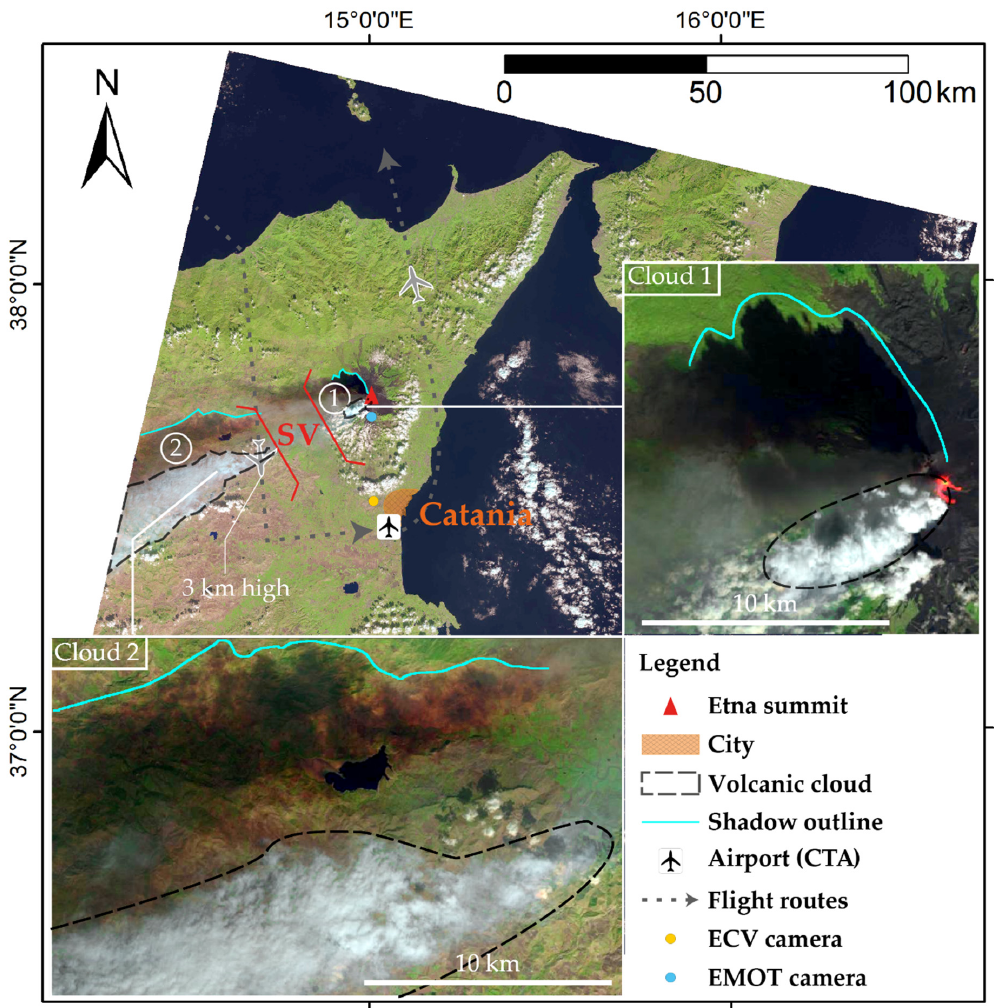
Figure 1. Ortho-rectified Landsat 8 OLI image of Mt. Etna acquired on 26 October 2013 at 09:37 UTC (courtesy of National Aeronautics and Space Administration (NASA)/United States Geological Survey (USGS)). Flight routes and altitudes for air traffic approaching Catania Fontarossa airport are taken from www.flightradar24.com. The two cameras from the INGV—Osservatorio Etneo camera network used in this paper are marked. A zoom on each cloud is given as inset. SV = Simeto Valley; CTA = Catania Fontanarossa airport.